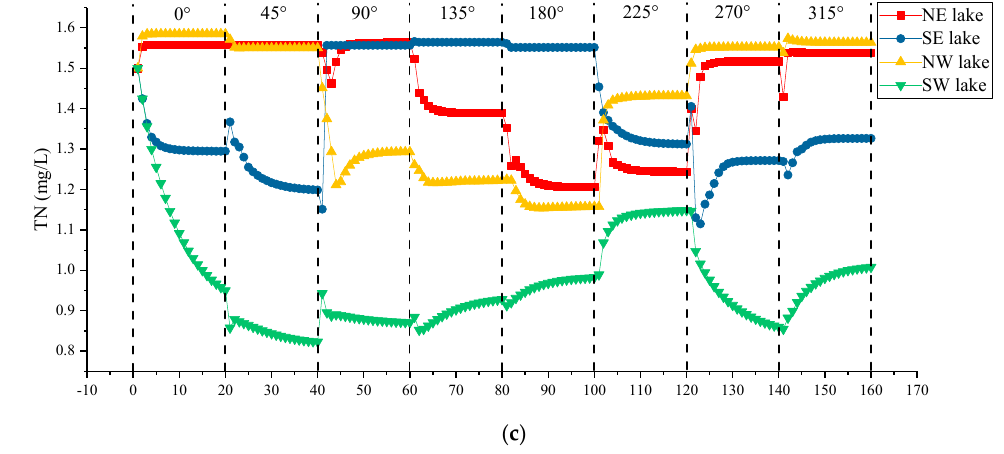
Figure 16. ( a , b ) are the concentration distribution of TP(total phosphorus) and TN(total nitrogen) under different directions of wind. From left to right and from the first row to the second row, the wind directions are: Northern (0°), Northeastern (45°), Eastern (90°), Southeastern (135°), Southern (180°), Southwestern (225°), Western (270°), Northwestern (315°); ( c ) shows the changes in water quality under different wind directions for different lake districts in Xuanwu Lake.